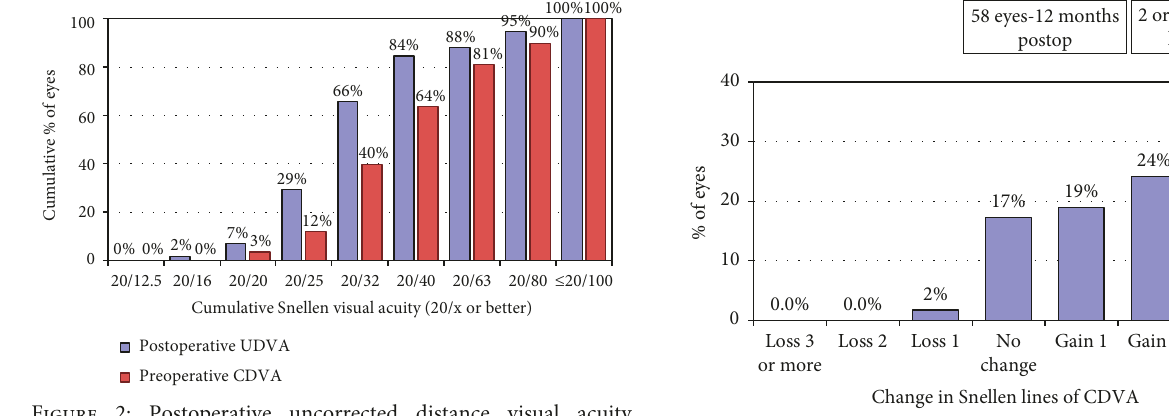
Figure 3: Change in corrected distance visual acuity